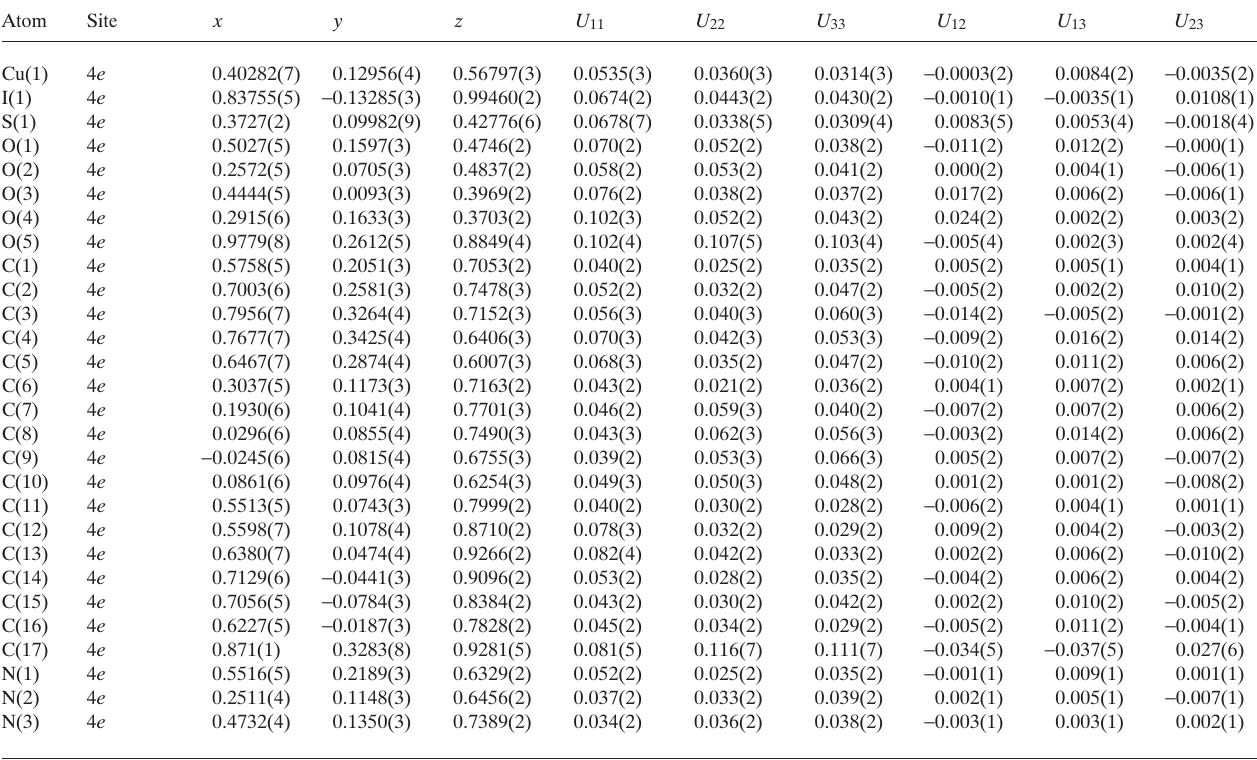
Table 3. Atomic coordinates and displacement parameters (in Å 2 ) .